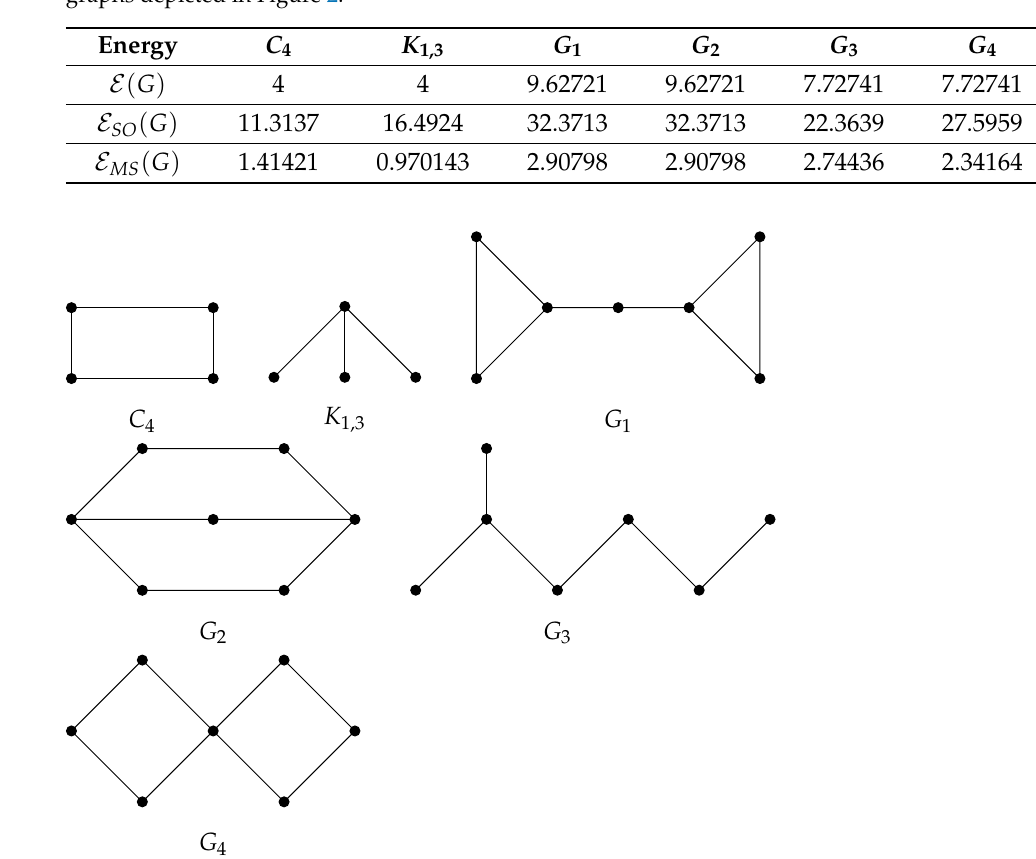
} and { G } are neither Sombor 3 , G 4 4 , K 1,3